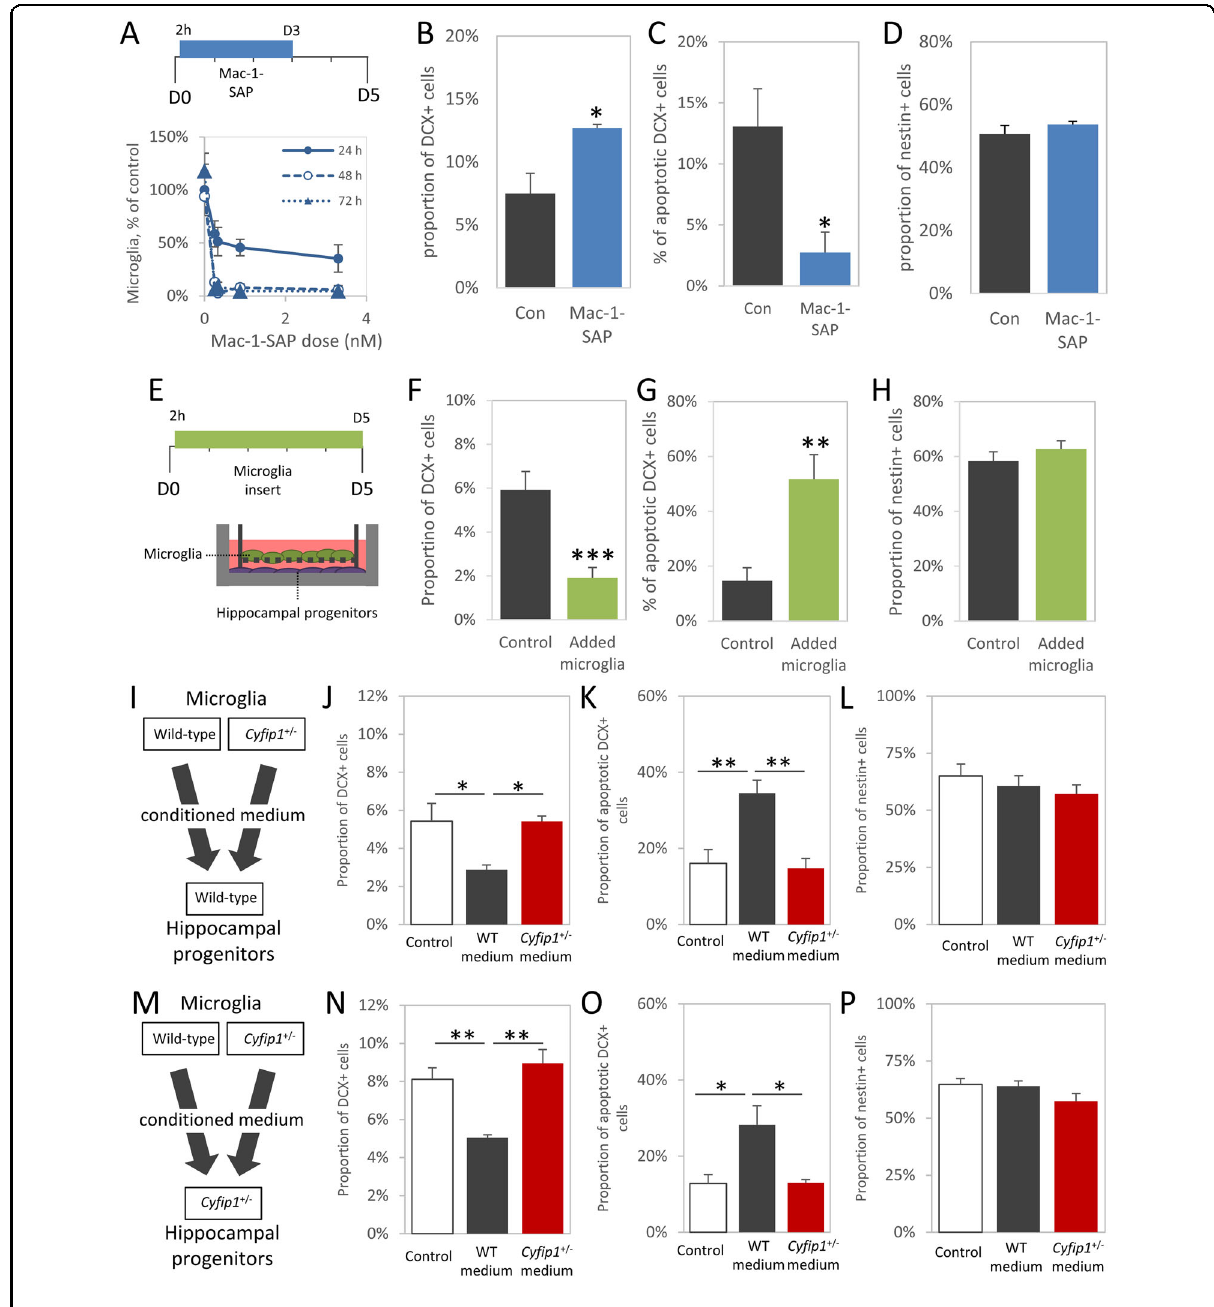
without any associated changes in the nestin + population = 1.07, p = 0.32, Fig. 3D), (50.7 ± 2.7% vs. 53.8 ± 1.0%, t (7) phenocopying the Cy fi p1 + / − cultures, and showing a signi fi cant role for microglia in regulating DCX